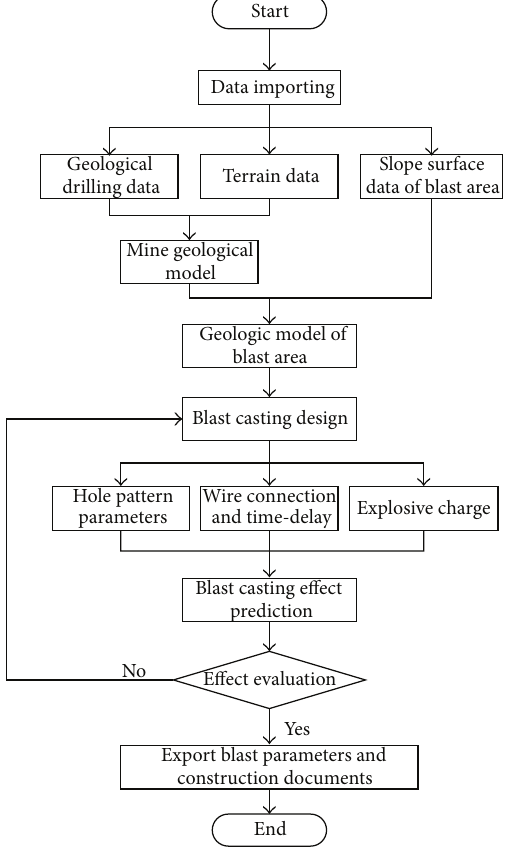
Figure 7: Flowchart of intelligent blast casting